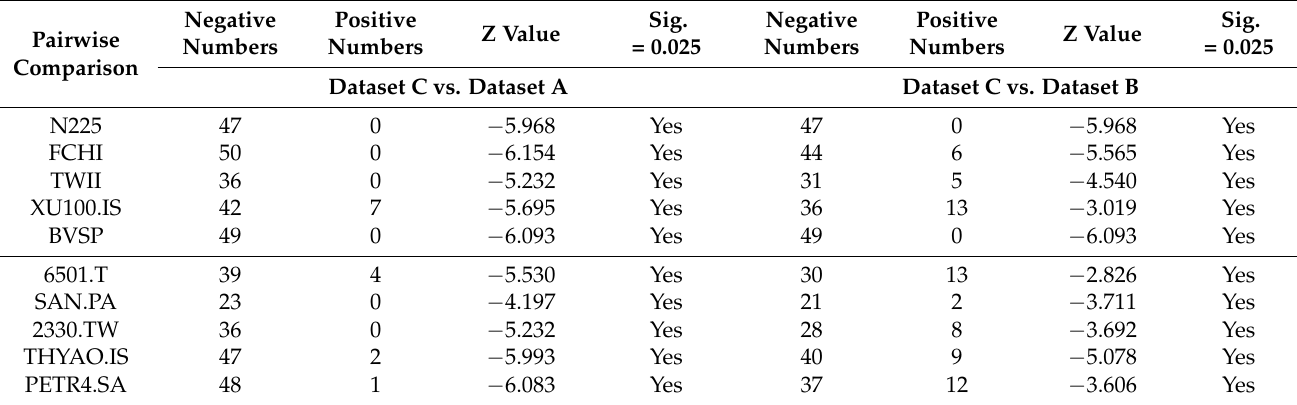
Table 10. The Wilcoxon signed–rank test of LSTMGA models in terms of dataset C to dataset A and dataset C to dataset B.